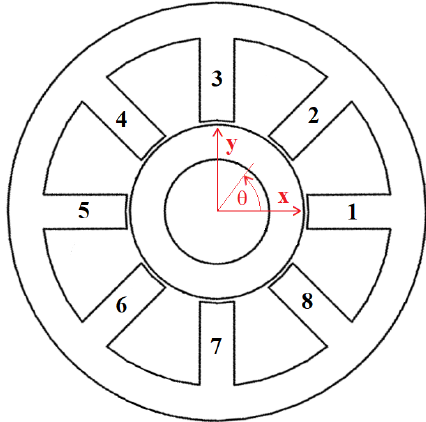
Figure 3. Common eight–pole radial magnetic